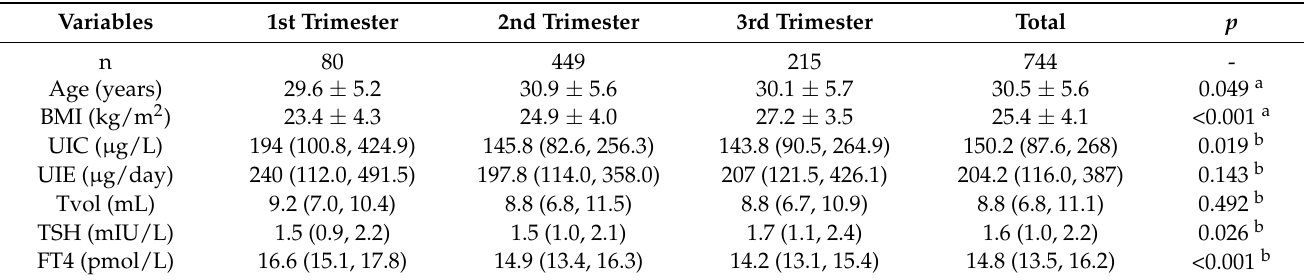
Table 2. Characteristics of pregnant women (N =